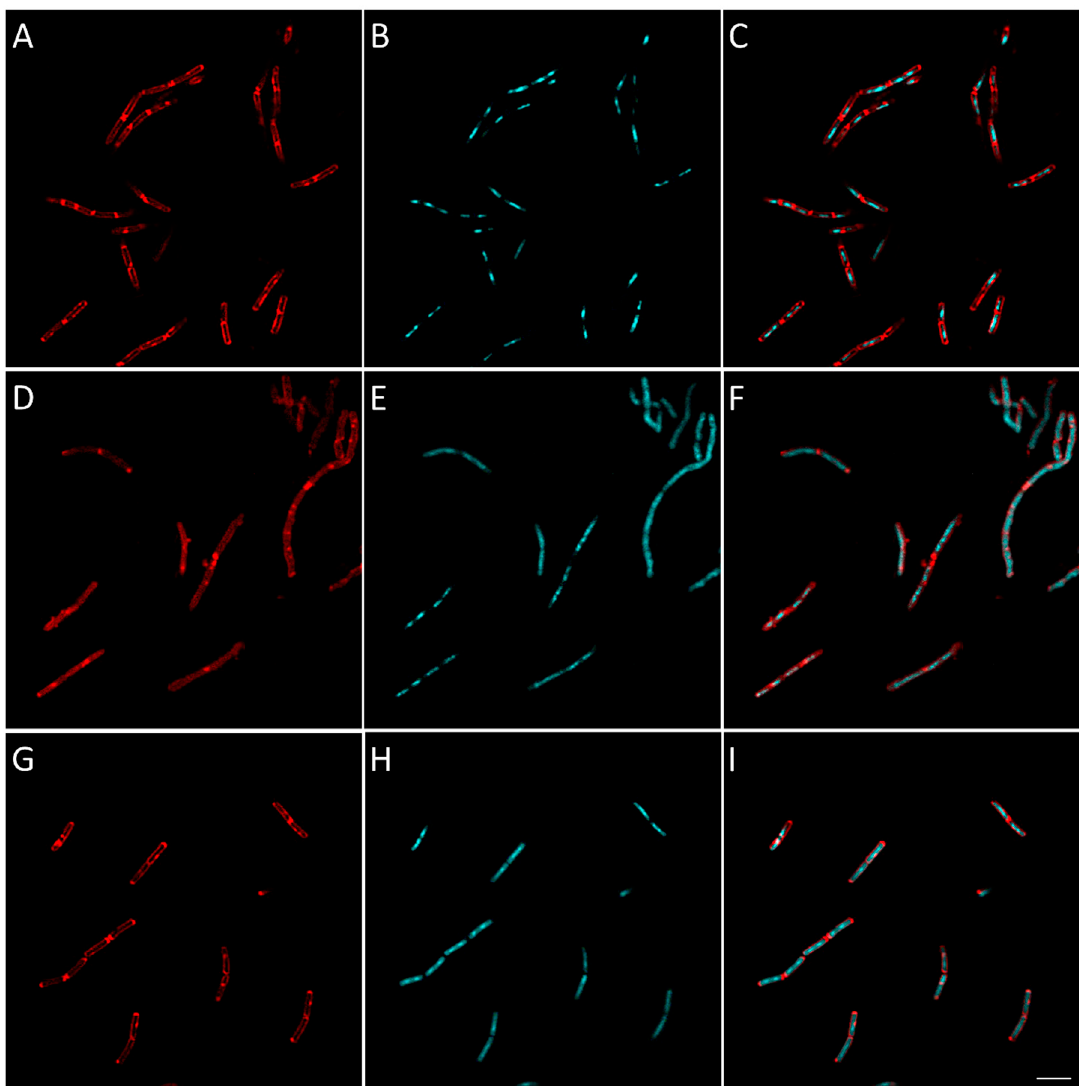
Figure 8. Morphological bacterial changes caused by compound 16 in B. subtilis . Morphological changes of B. subtilis caused by compound 16 were studied as explained in the Materials and Methods section. B. subtilis was incubated for 2 h at 37 °C in aerobic conditions with 4 X MIC of 16 ( D – F ). Control ( A – C ) was bacteria with no antibiotics added. At the end of the incubation, bacteria were fixed and membrane ( A , D , G ) and DNA ( B , E , H ) were stained using FM4-64FX (red signal) and DAPI (blue signal), respectively. Membrane and DNA signals were merged in the figure in ( C , F , I ). The effect of amoxicillin, an inhibitor cell wall synthesis, is shown for comparison in ( G – I ). Bacteria were observed using confocal microscope and images representative of observed effect were taken. The white scale bar on the bottom right corner corresponds to 4 µm.